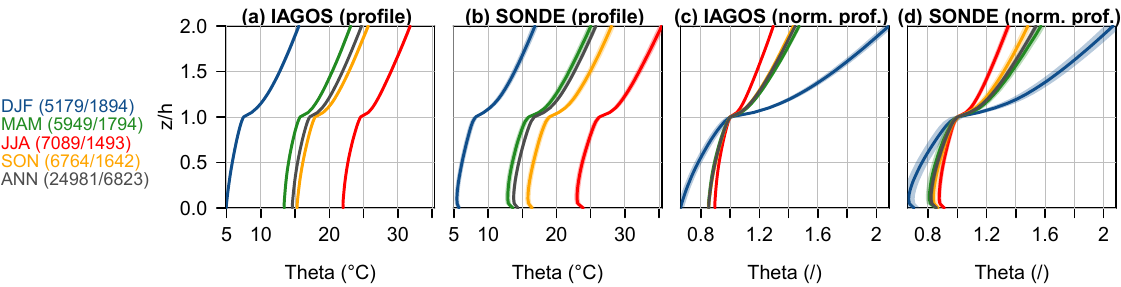
Figure 8. IAGOS and ozonesonde PBL-referenced ( a, b ) and normalized profiles ( c, d ) of daytime potential temperature. The number of profiles accounted for is indicated for each season (in brackets: IAGOS / SONDE).